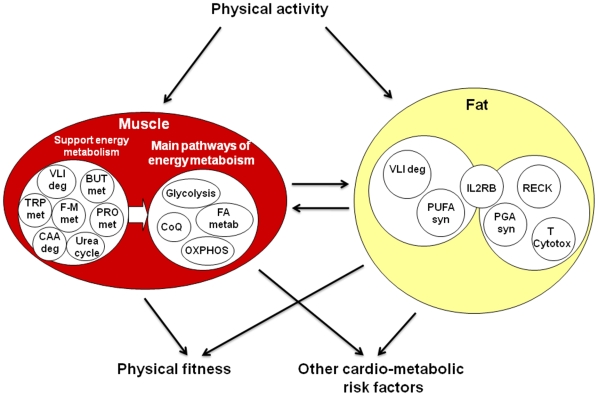
Up-regulated gene sets in muscle and fat tissue and their association with cardio-metabolic risk.Among the physically active members of twin pairs, as compared to their inactive co-twins, gene expression in the skeletal muscle was up-regulated for the central pathways of energy metabolism and supportive metabolic pathways related especially to the processes of oxidative energy production. In fat tissue the pathways were related e.g. to branched-chain amino acid degradation and PUFA synthesis. These metabolic changes were associated with decreased cardio-metabolic risk, including an increase in aerobic fitness. Centroids: OXPHOS, Oxidative phosphorylation; VLI deg, Valine, leucine and isoleucine degradation; CoQ, Ubiquinone biosynthesis; PRO met, Propanoate metabolism; FA metab, Fatty acid metabolism including mitochondrial β-oxidation and peroxisomal β-oxidation; BUT met, Butanoate metabolism; TRP met, Tryptophan metabolism; F-M met, Fructose and mannose metabolism; CAA deg, Chloroacrylic acid degradation; Urea cycle, Urea cycle and metabolism of amino groups; IL2RB, IL2RB pathway; PUFA syn, Polyunsaturated fatty acid biosynthesis; RECK, RECK pathway; PGA syn, Prostaglandin synthesis regulation; T Cytotox, T cytotoxic pathway.